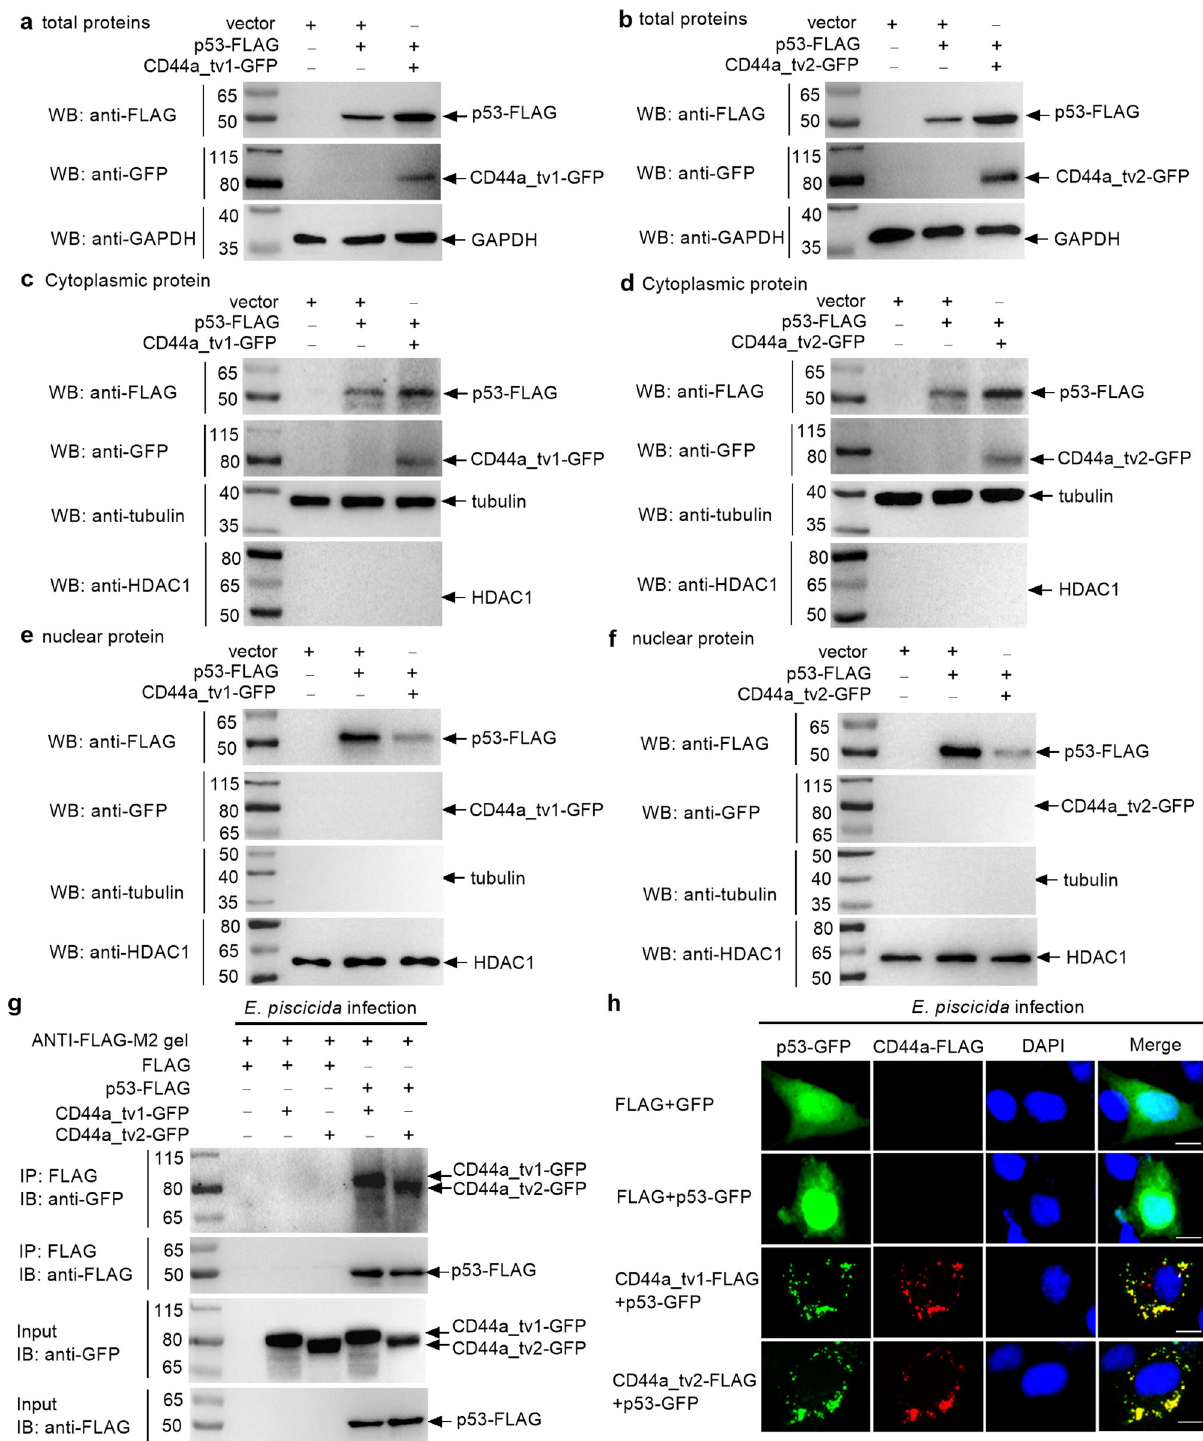
Fig. 6 Zebra fi sh CD44a variants promote the translocation of p53 from the nucleus to the cytoplasm and interact with p53 in the cytoplasm. The effects of zebra fi sh CD44a_tv1 ( a ) and CD44a_tv2 ( b ) on the expression of total p53 proteins. The effects of zebra fi sh CD44a_tv1 ( c ) and CD44a_tv2 ( d ) on the expression of cytoplasmic p53 proteins. The effects of zebra fi sh CD44a_tv1 ( e ) and CD44a_tv2 ( f ) on the expression of nuclear p53 proteins. g The interaction between zebra fi sh CD44a variants and p53. For a – g , WB were repeated at least two times, and shown were the representative data. h The colocalization between zebra fi sh CD44a variants and p53 in the CD44a − / − -14del cells following the E. piscicida infection. Scale bar, 10 µ m.